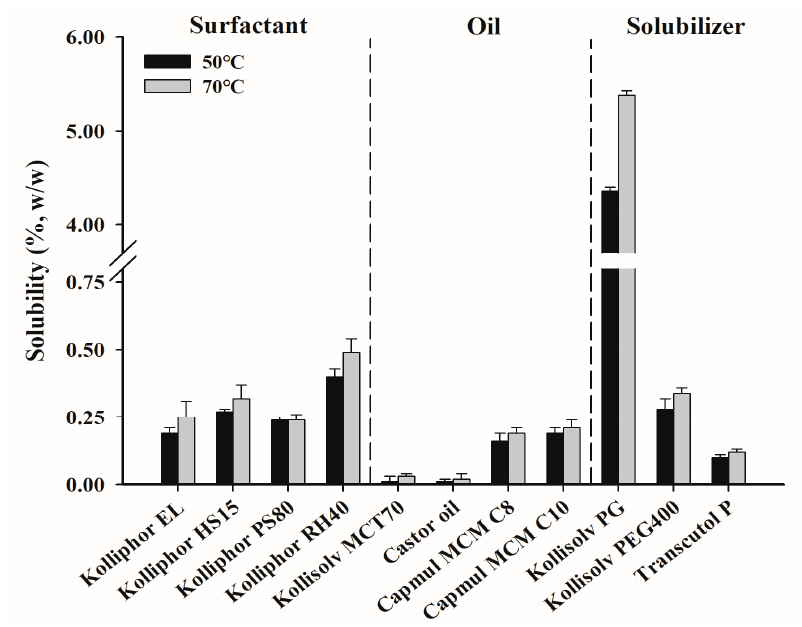
RH40 (surfactant) and Capmul MCM C8 and Capmul MCM C10 (oil) were selected at higher surfactant ratios of 6/4–9/1. Figure 2. The solubility of PZH in various surfactants, oils, and solubilizers.